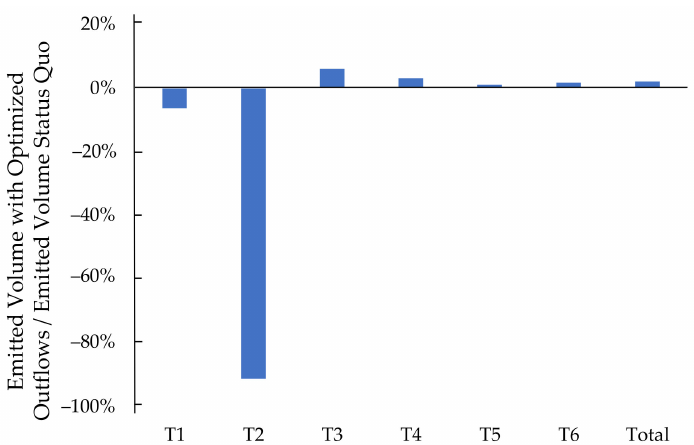
Figure 11. Emitted volumes of all tanks and the total system relative to the emitted volumes of the status